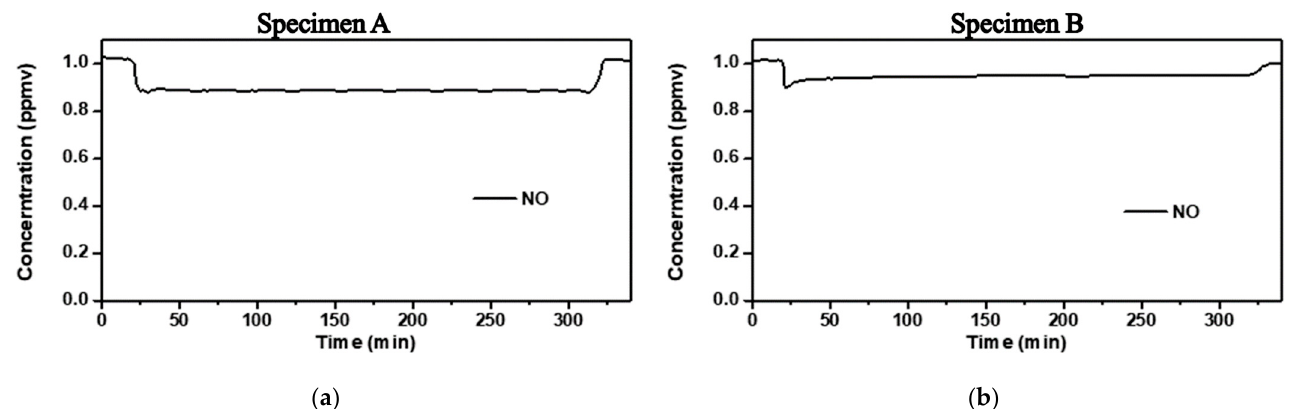
Figure 7. NO removal rate results for 6 h 30 min while UV-A is illuminated. ( a ) and ( b ), Ion chromatography result of specimen A and specimen B. Table 5. NO removal for each specimen, nitric acid ion weight and ratio analysis results. Division